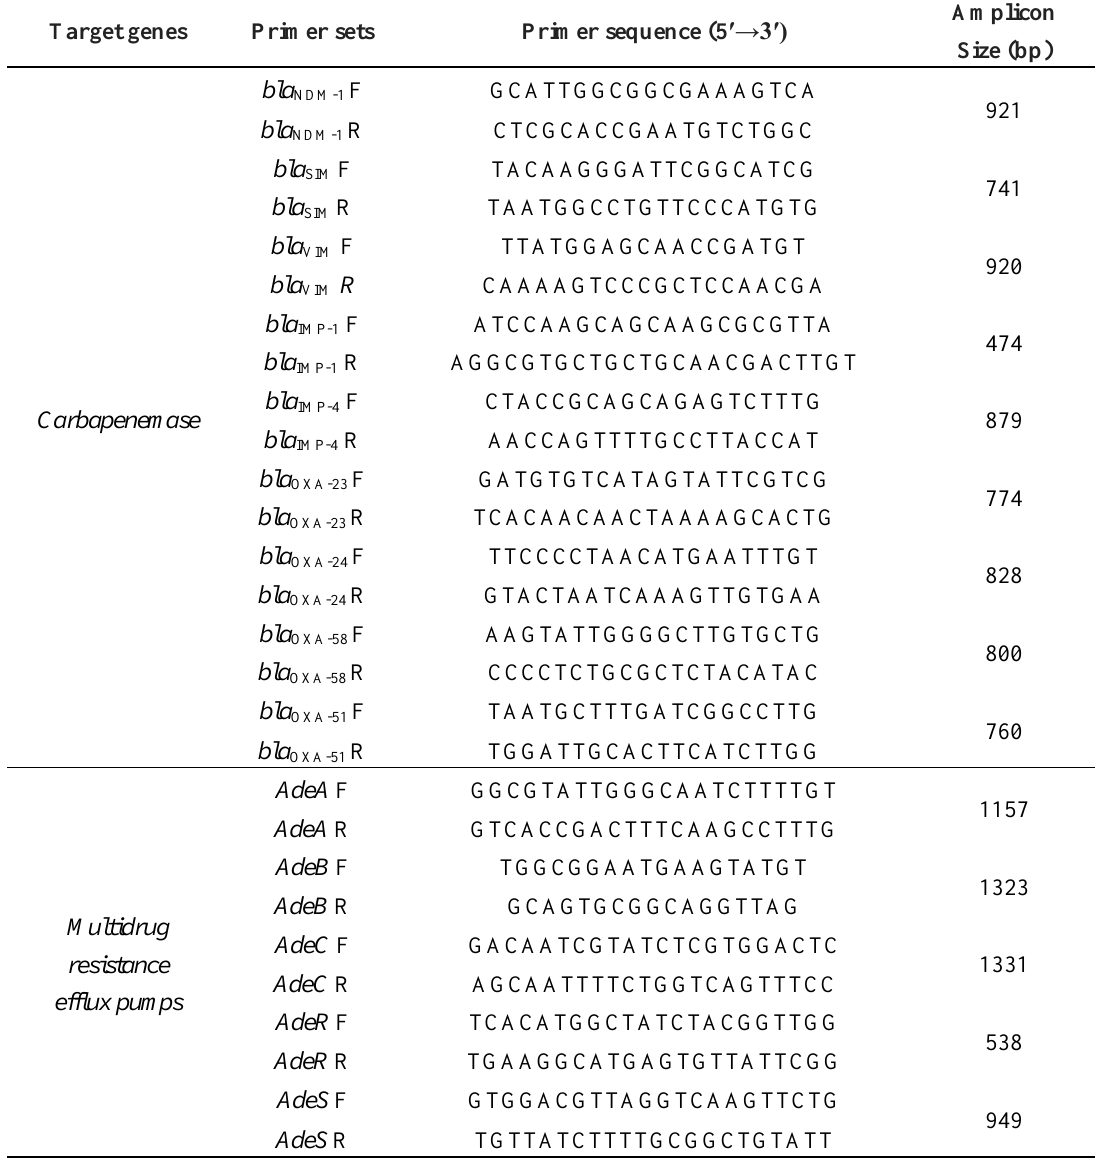
Table 1. Sequences of PCR primer sets for genes of carbapenemase and ABC efflux pumps of A. baumannii used in this